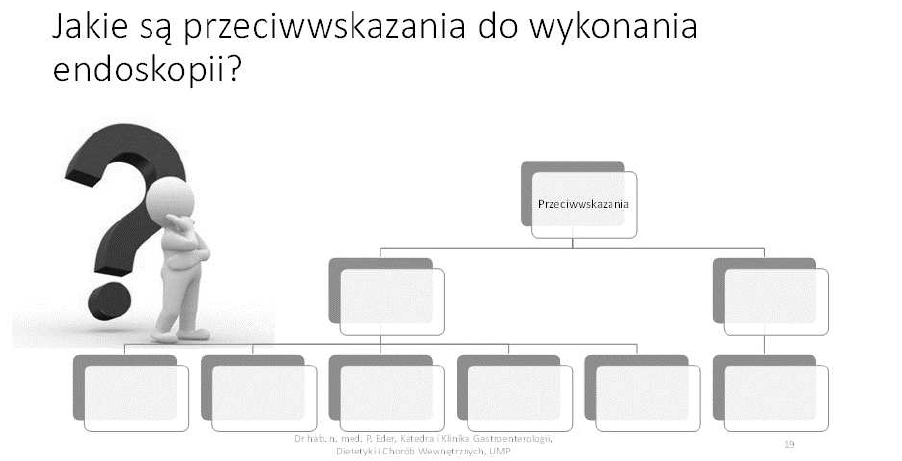
Figure 3. Questions during an e-learning lecture in Gastroenterology for year